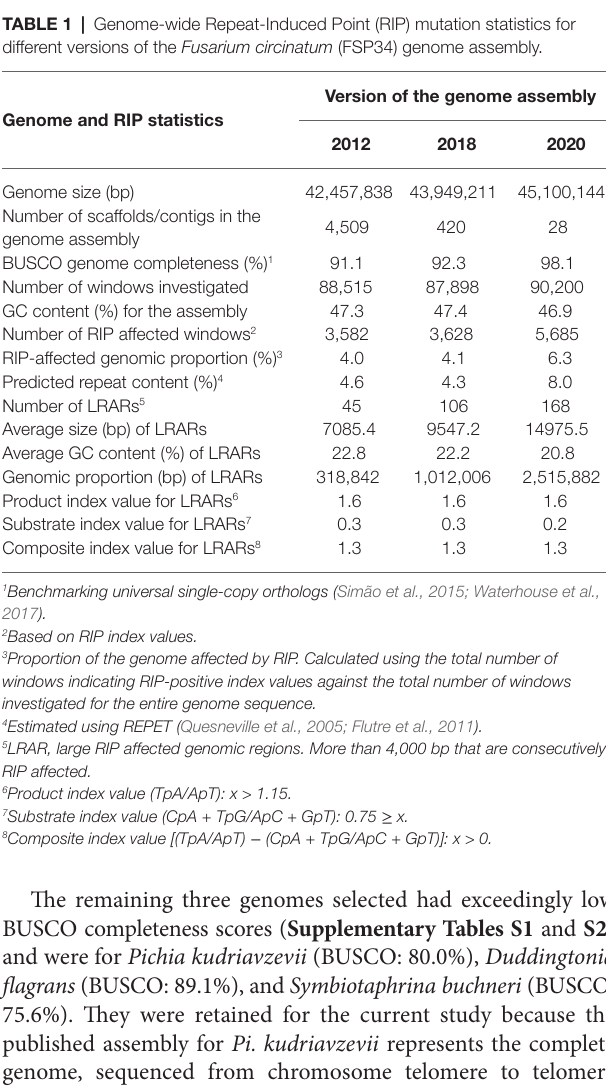
TABLE 1 | Genome-wide Repeat-Induced Point (RIP) mutation statistics for different versions of the Fusarium circinatum (FSP34) genome assembly.